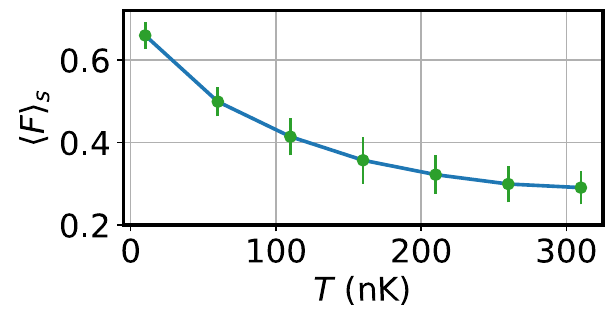
FIG. 7. The effect of contact with a thermal bath at temper- ature T upon the steady-state time-averaged overlap (cid:4) F (cid:3) s . The time average is considered to start at 10 ms, when the overlap has already achieved its steady value. The error bars correspond to one standard deviation. Each point is evaluated from 10 2 quan- tum trajectories. The coupling to the heat bath is κ = 0.1 ms × ω 2 and all remaining parameters are the same as in Fig. 6. t with error bars corresponding to one standard deviation.